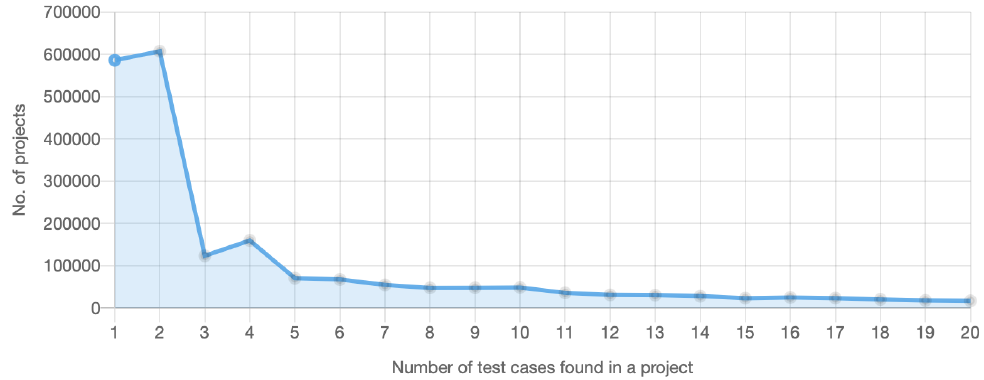
Figure 5. The real number of test cases in all GitHub projects with Java as a primary